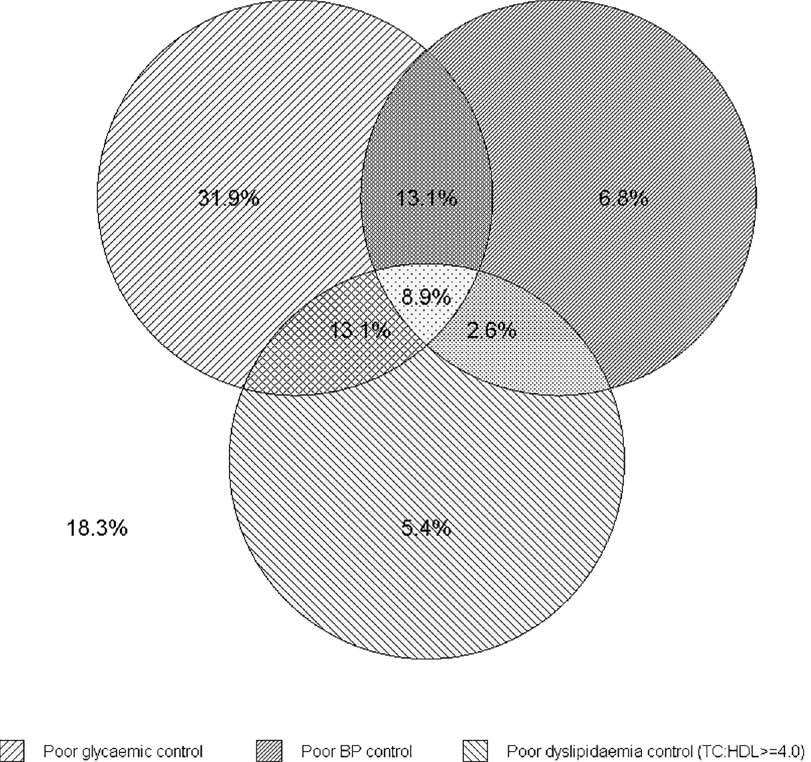
Fig 1. Proportion of participants with individual and combined indicators of poor diabetes control. This figure shows that 8.9% had poor glycemic, poor BP and poor lipid control, while 18.3% had good control of all three indicators. Note: 71 participants had missing data for either glycemic, BP or lipid control and were not includedin this figure (total n = 542).